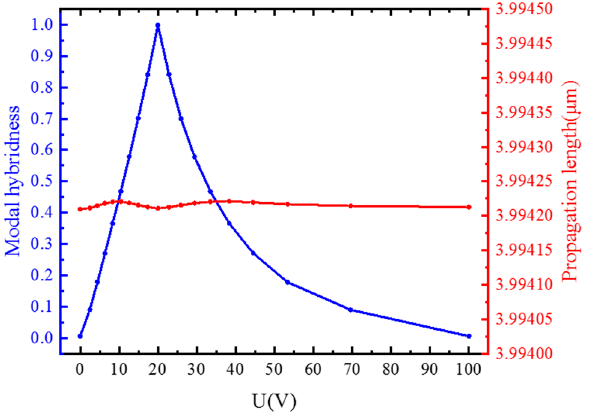
Figure 4. The relationship between the modal hybridness and the conversion length with the potential difference between the two ends of the liquid crystal.